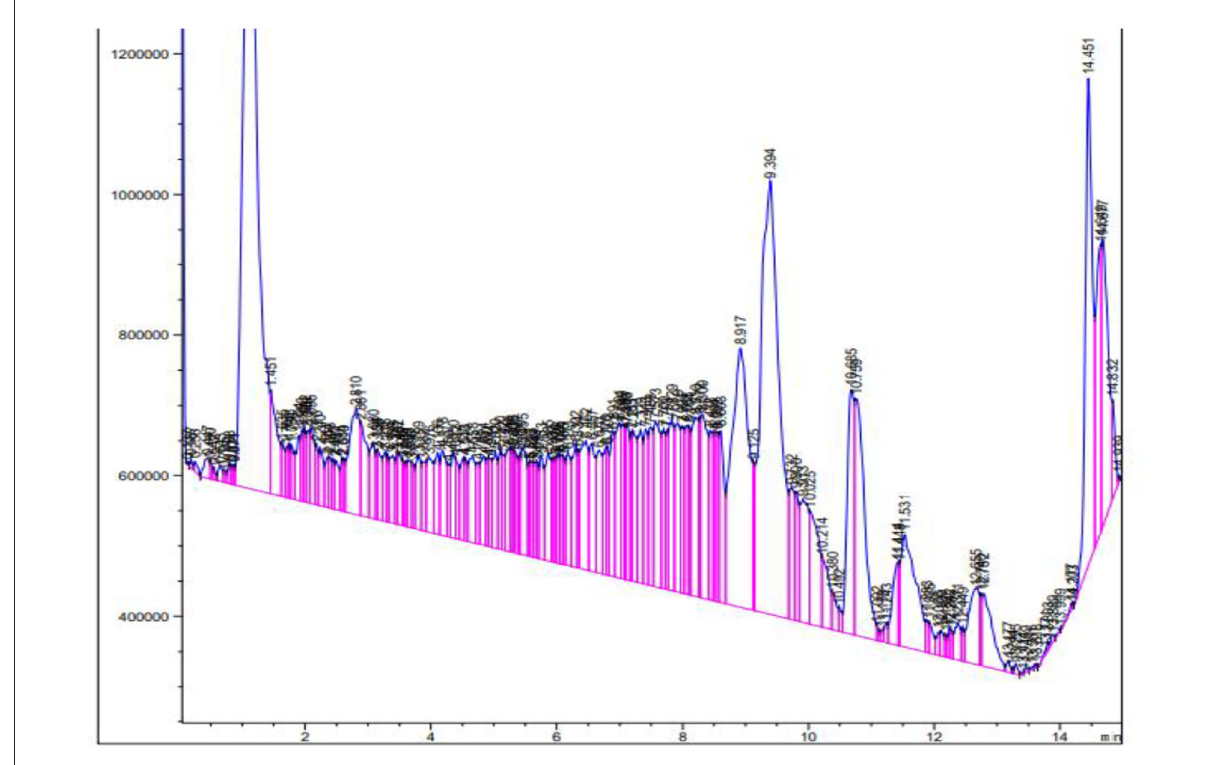
FIGURE13 Chromatogram of flower extracts from B. aurea analyzed by the LCMS